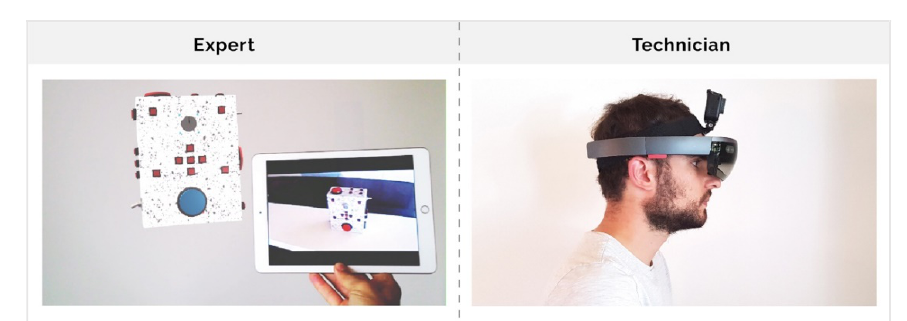
Figure 7. Role-specific perspectives of the DTF (photo use permitted by Luca